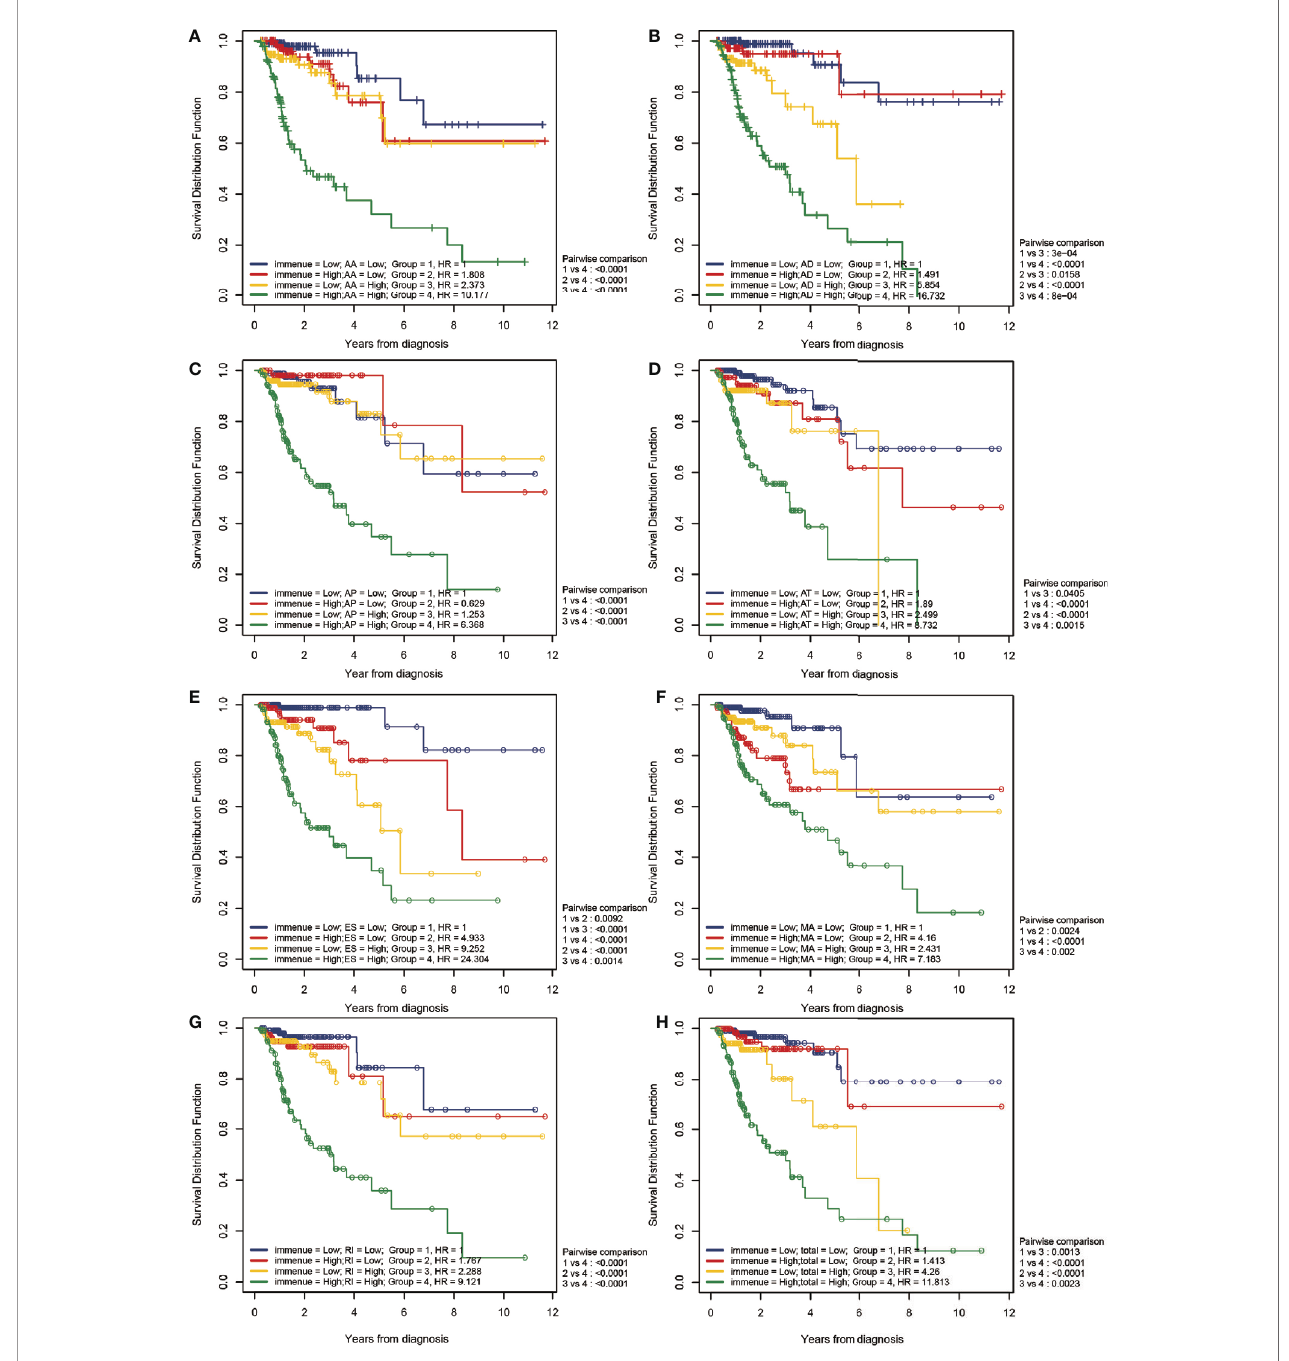
FIGURE 8 | Correlation between the TII risk and AS events. (A – H) represents the AS events AA, AD, AP, AT, ES, ME, RI, and total events, respectively. We conducted a two-factor analysis to identify the risk of different AS events with TII risk in 4 groups: Group 1 (immune risk = Low; AS risk = Low), Group 2 (immune risk = High; AS risk = Low), Group 3 (immune risk = Low; AS risk = High), and Group 4 (immune risk = High; AS risk =